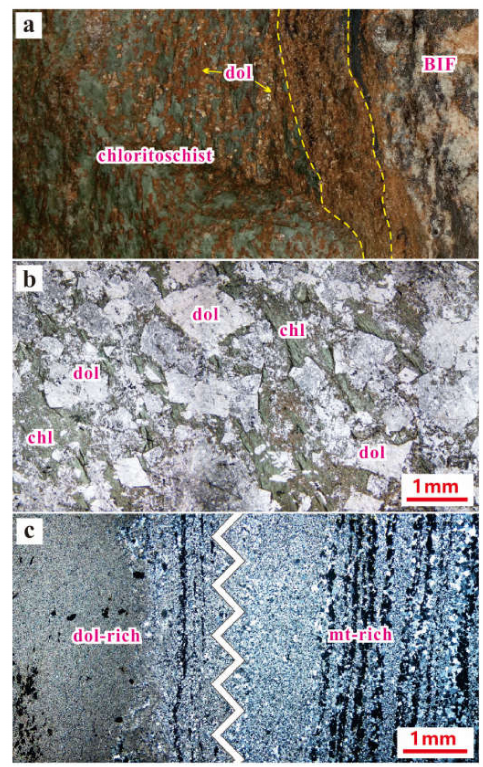
Figure 3. ( a ) Photograph showing the dolomite enrichment in the BIF–chlorite-schist contact zone. ( b ) Photomicrograph of the dolomite porphyroblasts and chlorite-dominated matrix in the chlorite schist. ( c ) Photomicrographs of dolomite-rich and magnetite-rich subtypes of BIF. dol: dolomite; chl: chlorite; mt: